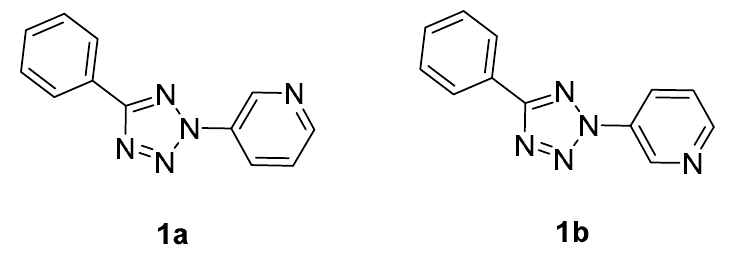
Figure 5. Rotamers of 3-(5-phenyl-2 H -tetrazol-2-yl)pyridine 1a , 1b . Energies (E) and dipole moments ( µ ) of different rotamers of 3-(5-phenyl-2 H -tetrazol-2-yl)pyridine 1 are shown in Table 2. Table 2. Energies (E) and dipole moments ( µ ) of different rotamers of 3-(5-phenyl-2 H -tetrazol-2-yl)pyridine 1 calculated by means of DFT B3LYP method in the gas phase and ethanol (IEFPCM